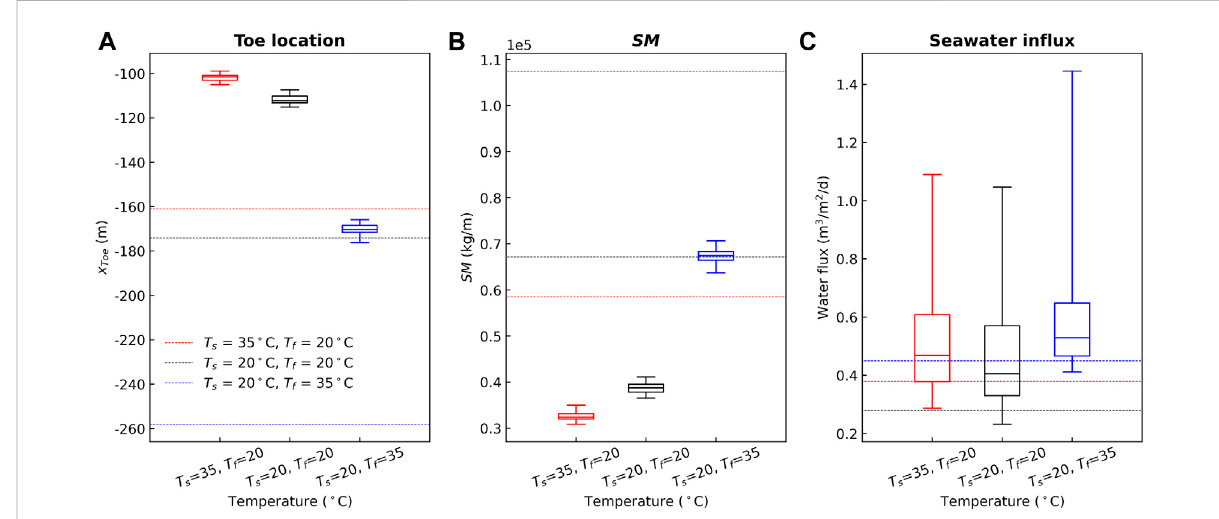
FIGURE 6 Box plots ( n = 50) for the heterogeneous aquifers subjected to different FW-SW temperature contrasts. The left-hand, middle and right-hand panels are the results for (A) the toe location, (B) the total amount of salt mass stored in the aquifer ( SM ), and (C) the total seawater in fl ux across the aquifer-sea interface, respectively. The dashed lines are the results for homogeneous aquifers. T s and T f are seawater and freshwater temperatures,